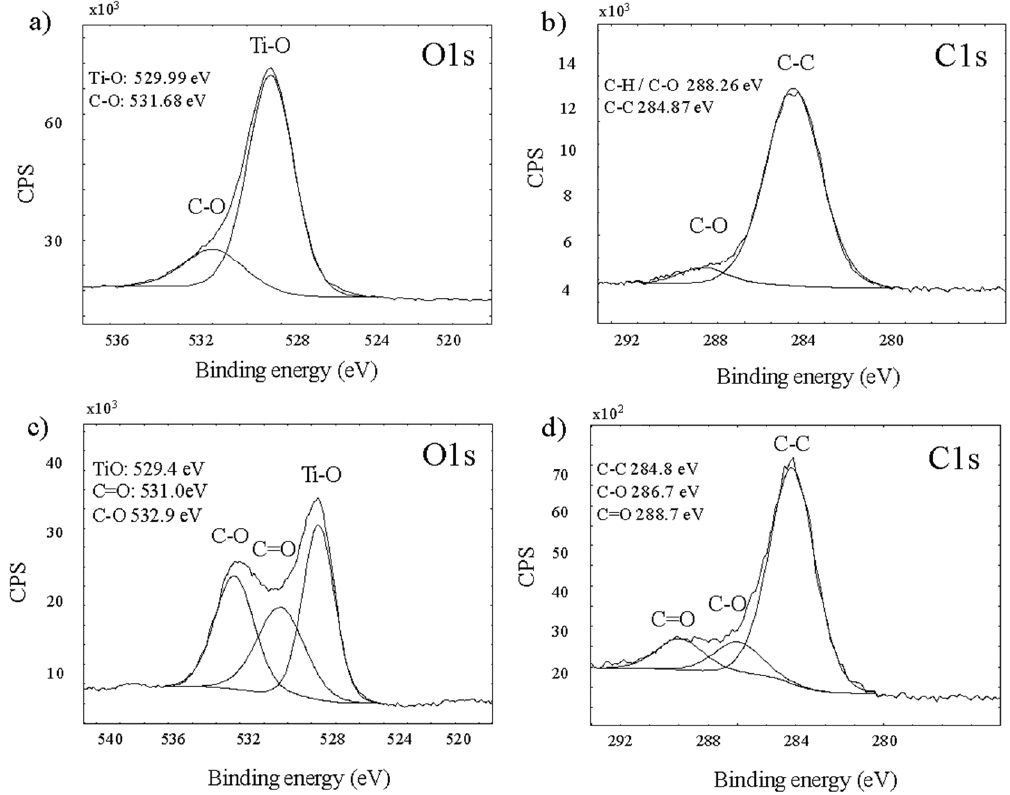
Figure 6. The O1s and C1s X-ray photoelectron spectroscopy (XPS) spectrums of immobilized for ( a , b ) unwashed TP2 and ( c , d ) washed TP2. CPS, cycles per second.